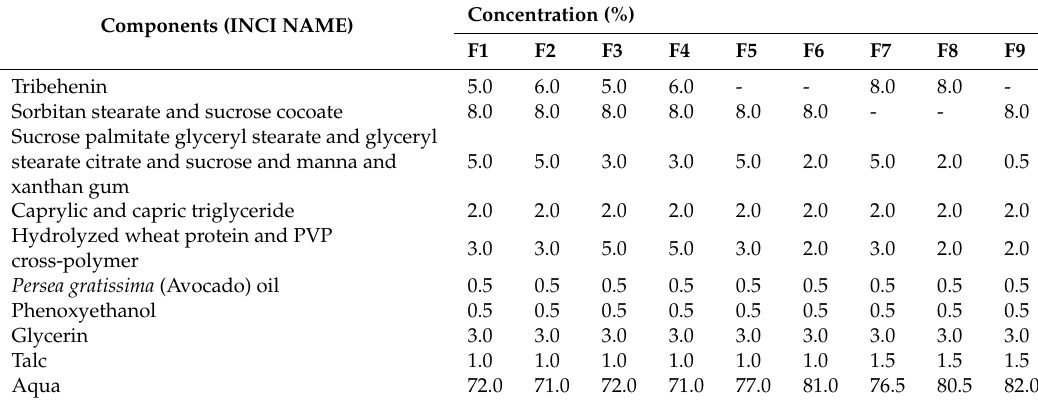
Table 1. Components of oil-in-water